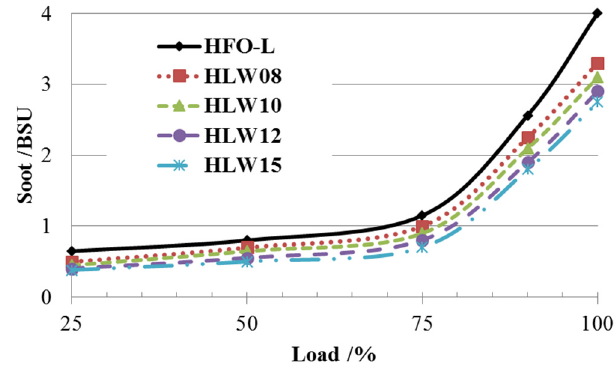
Figure 16. Variation tendency of soot. BSU—Bosch smoke unit.